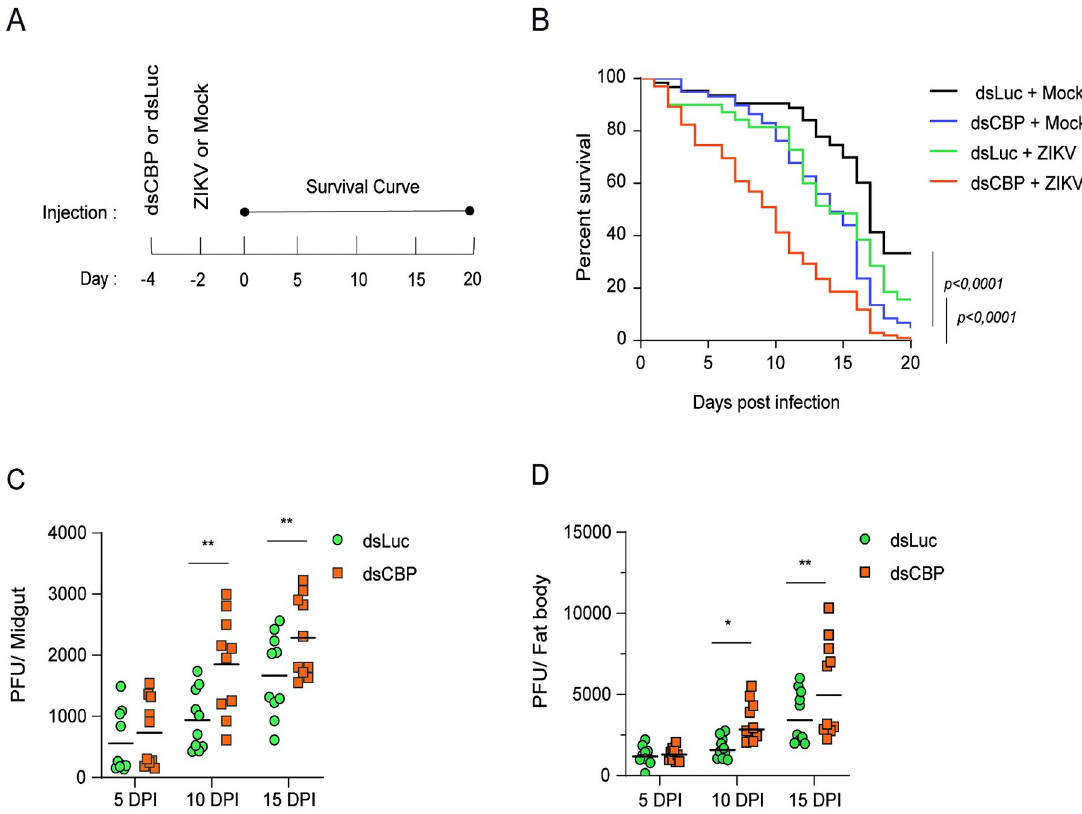
Fig 3. AaCBP gene knockdown compromises the lifespan of ZIKV-infected mosquitoes. A. One hundred adult female mosquitoes were injected intrathoracically with double-stranded RNAs for the AaCBP or Luc control gene, two days before Zika infections (by intrathoracic injections). Survival of the mosquitoes was monitored on a daily basis, until Day 20. B. The experiments were conducted in five 500ml cups, each containing 20 mosquitoes. Dead mosquitoes were removed on a daily basis. The survival curves were repeated at least five times. Survival curve of mosquitoes that were not injected, mock-infected mosquitoes that were injected with for dsLuc or dsAaCBP, and mosquitoes that were injected with for dsLuc or dsAaCBP and infected with ZIKV. C and D. Midguts or fat bodies from silenced mosquitoes were assessed for virus infection intensity at different time points. Each dot or square represents the mean plaque- forming units (PFUs) per two midguts or fat bodies (totaling 20 midguts or fat bodies examined) from five independent experiments. Bars indicate the standard error of the mean; statistical analyses were performed by Student’s t test. � , p < 0.05; �� , p <